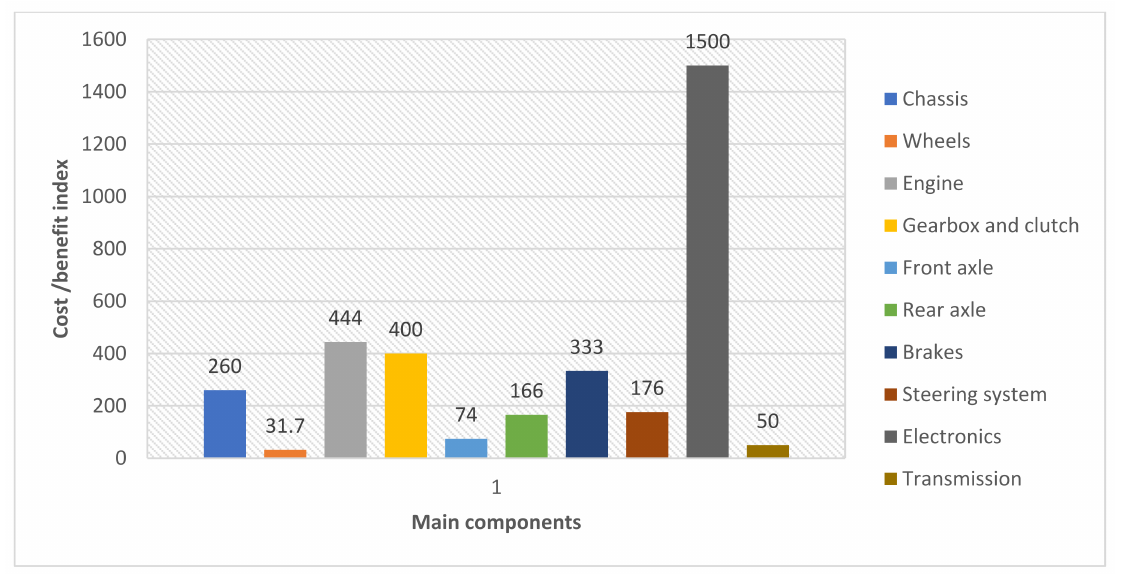
Figure 3. Cost–benefit index of the main